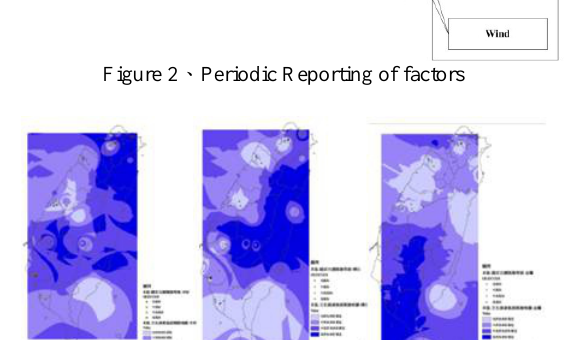
Figure 2 、 Periodic Reporting of factors